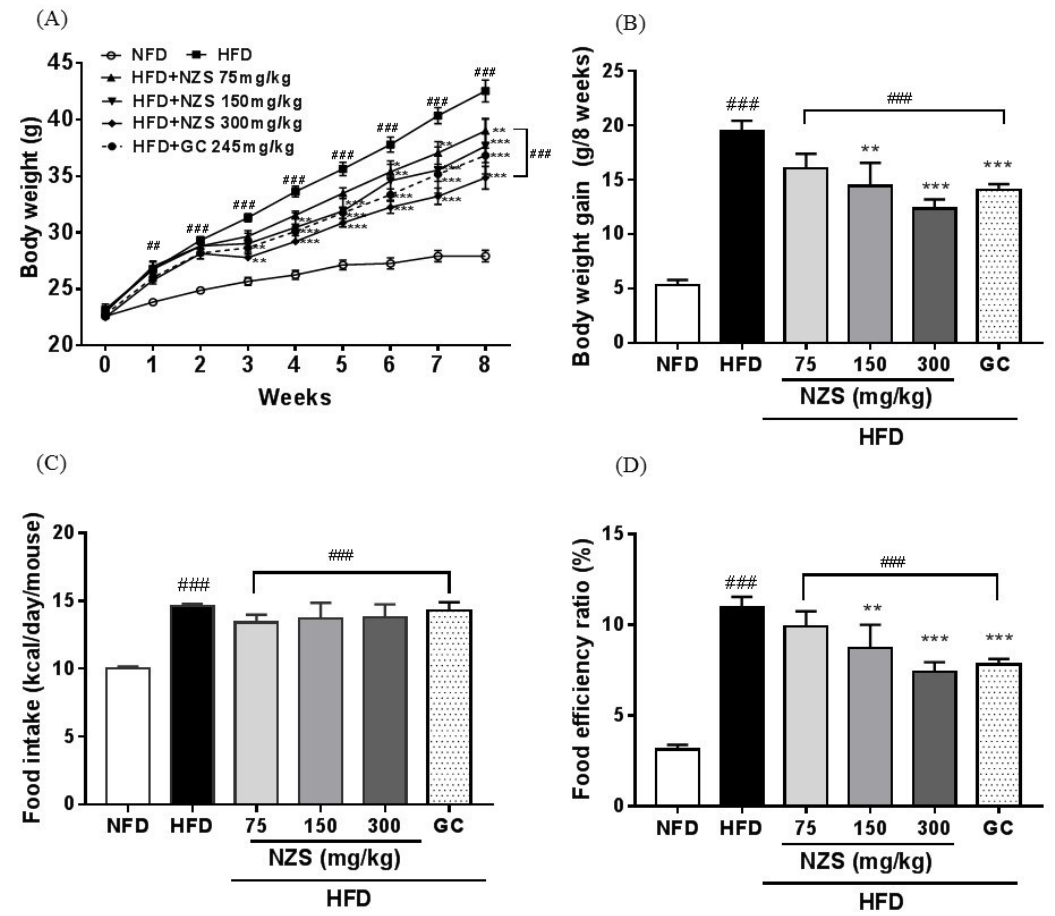
Figure 1. Effects of Tetragonia tetragonoides (Pall.) Kuntze extract (New Zealand spinach, NZS) on body weight gain and food intake in high-fat diet (HFD)-induced obese mice. ( A ) Body weight, ( B ) body weight gain, ( C ) food intake rate, and ( D ) food efficiency ratio. NFD: normal-fat diet; GC: Garcinia cambogia extract. Values are expressed as mean ± standard error of the mean (SEM) ( n = 5). ## p < 0.01 and ### p < 0.005 versus the NFD group; ** p < 0.01 and *** p < 0.005 versus the HFD group.